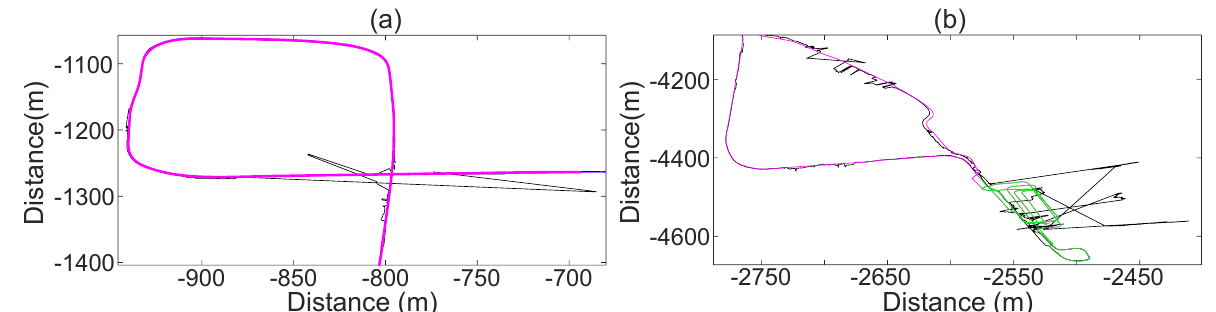
Figure 12. Shown is the vehicle position as measured by a SatNav receiver (black) and as estimated by means of statistical filtering (blue, magenta and green). ( a ) Shows the dataset section of a bridge underpass. ( b ) Shows the dataset section of a parking structure.